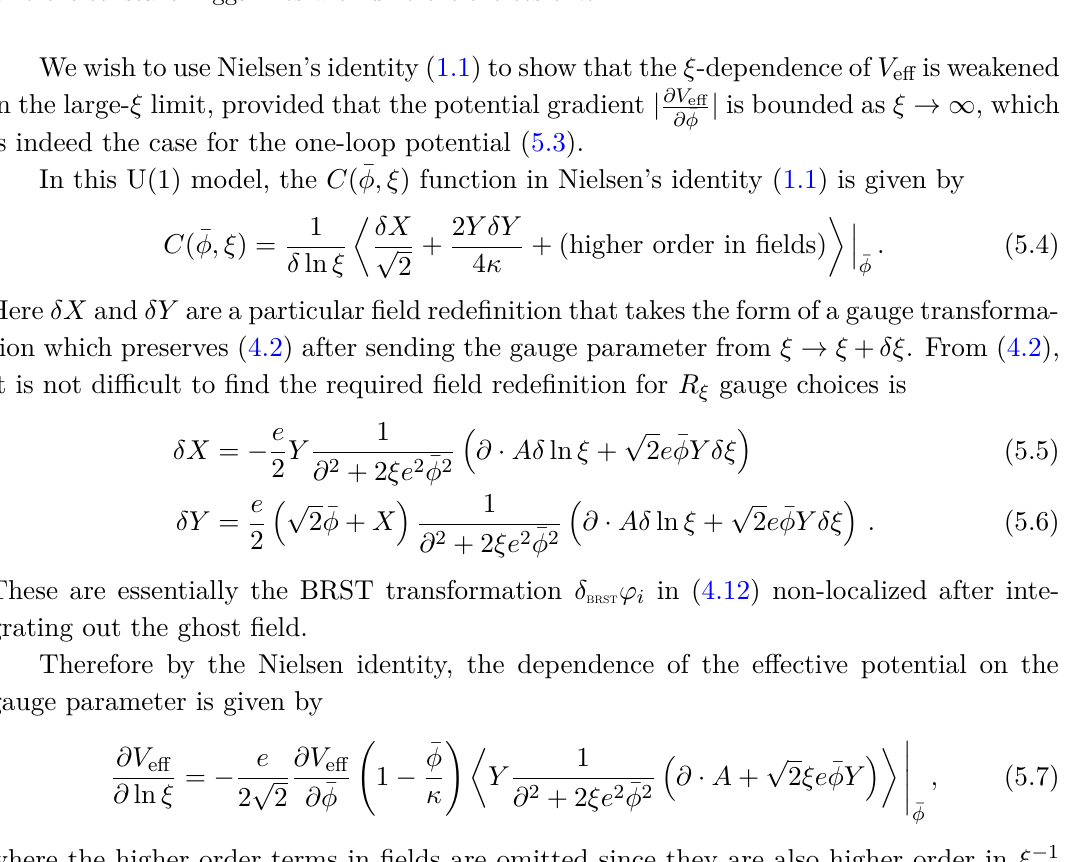
Figure 3 . The κ parameter stands for different choices of local coordinate systems on R 2 spanned by X, Y . For a given choice of coordinate, the Goldstone mode fluctuations across the average field ¯ φ along a constant Higgs line, whose curvature radius is given by κ . In this figure, we have shown different constant Higgs lines with different choices of κ